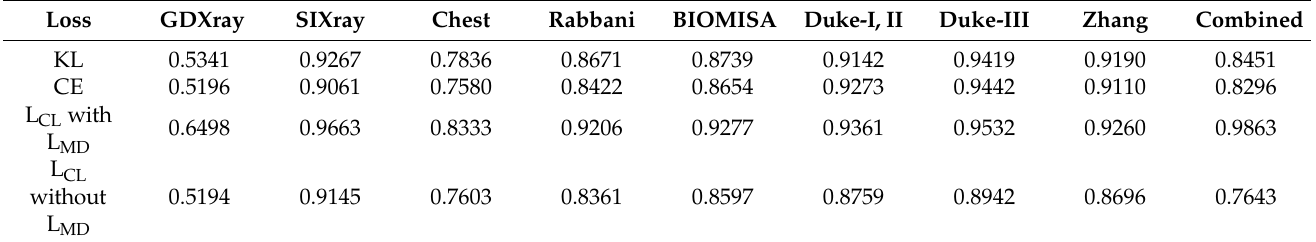
Table 11. Performance comparison of the KD divergence, cross-entropy (CE), and L CL (with and without L MD ) on different